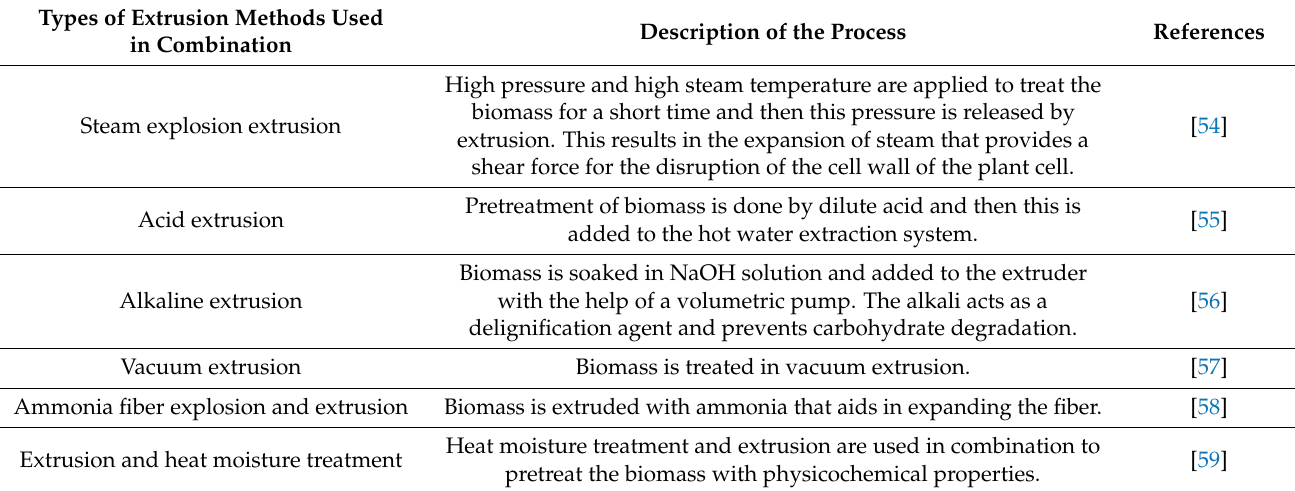
Table 2. Summary of different types of extrusion methods used in